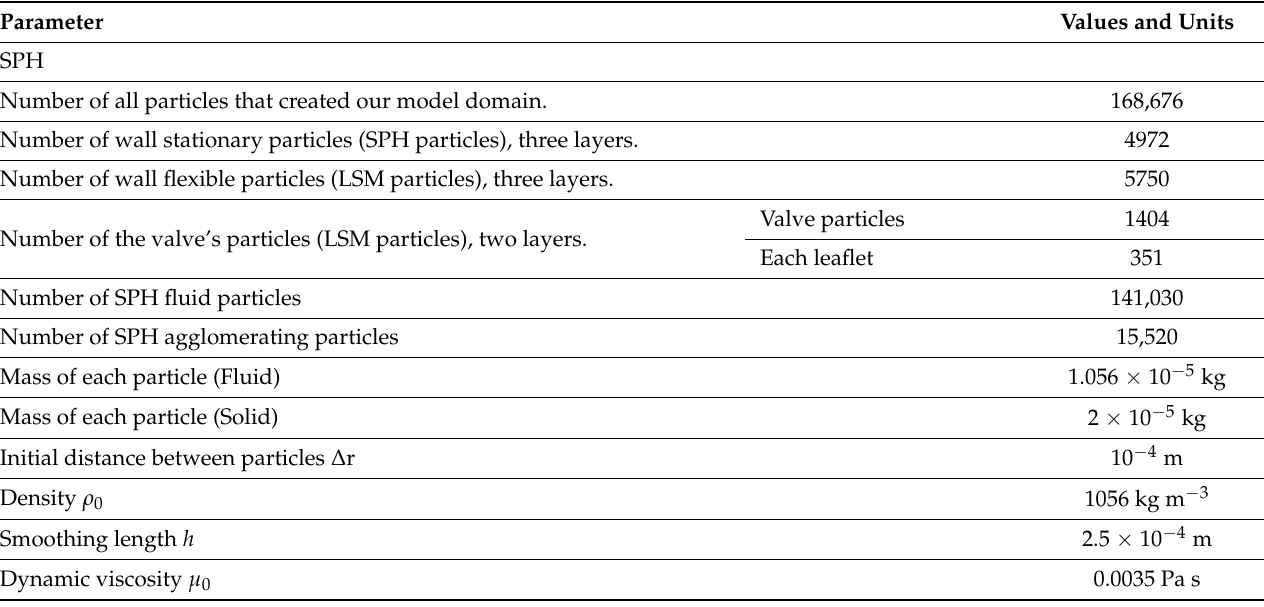
Figure 2. Two-dimensional geometry and structure of a dual venous valve: ( a ) geometry showing the location of the contraction forces and ( b ) geometry showing the computational particles and their location in the model. Table 1. Model’s numerical